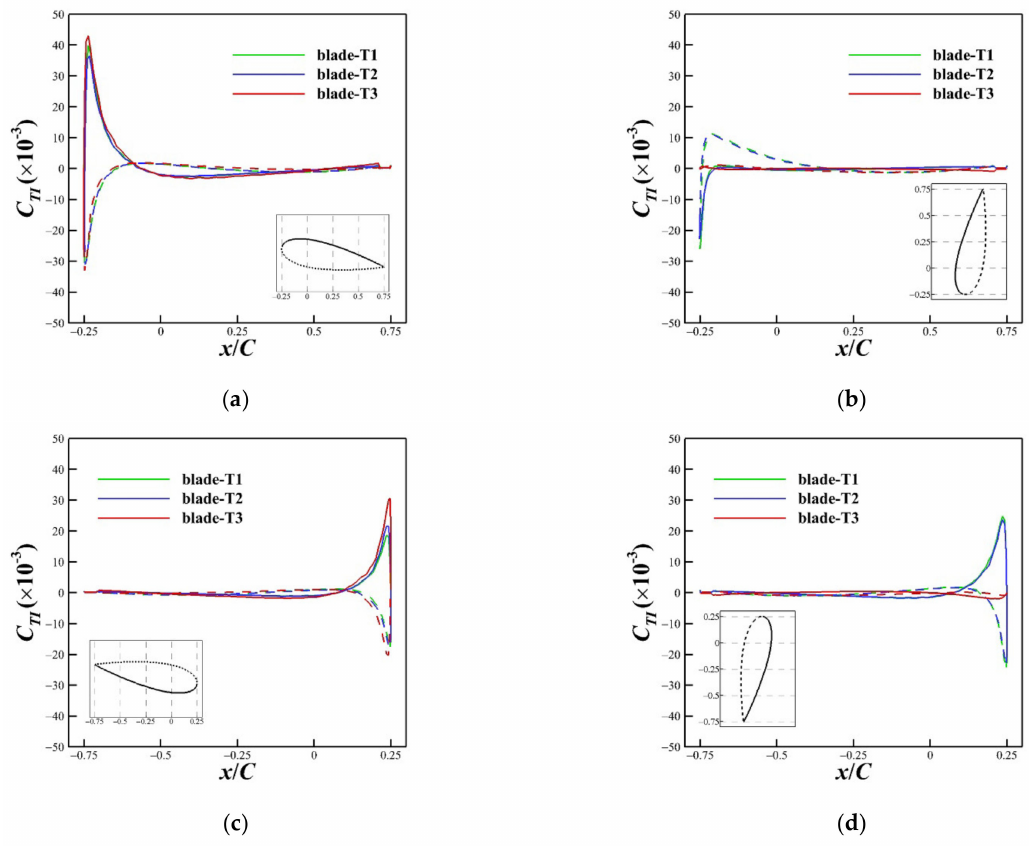
Figure 19. Hysteretic curves of surface pressure over a blade in a cycle ( L = 2) for ( a ) θ = 0 ◦ , ( b ) θ = 90 ◦ , ( c ) θ = 180 ◦ , and ( d ) θ = 270 ◦ .